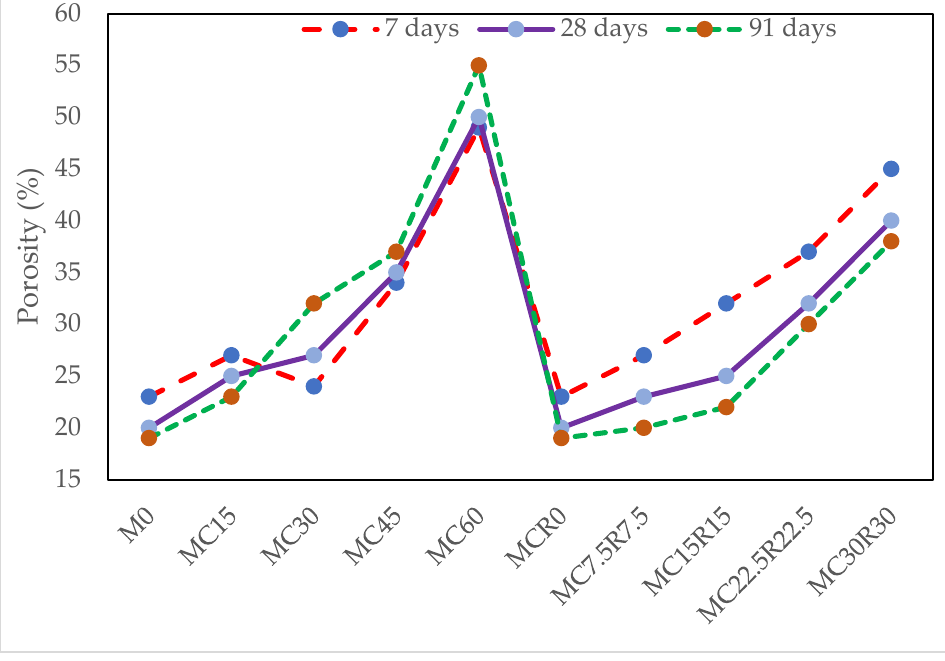
Figure 11. Influence of cementitious waste replacement on the porosity of alkali-activated mortar.